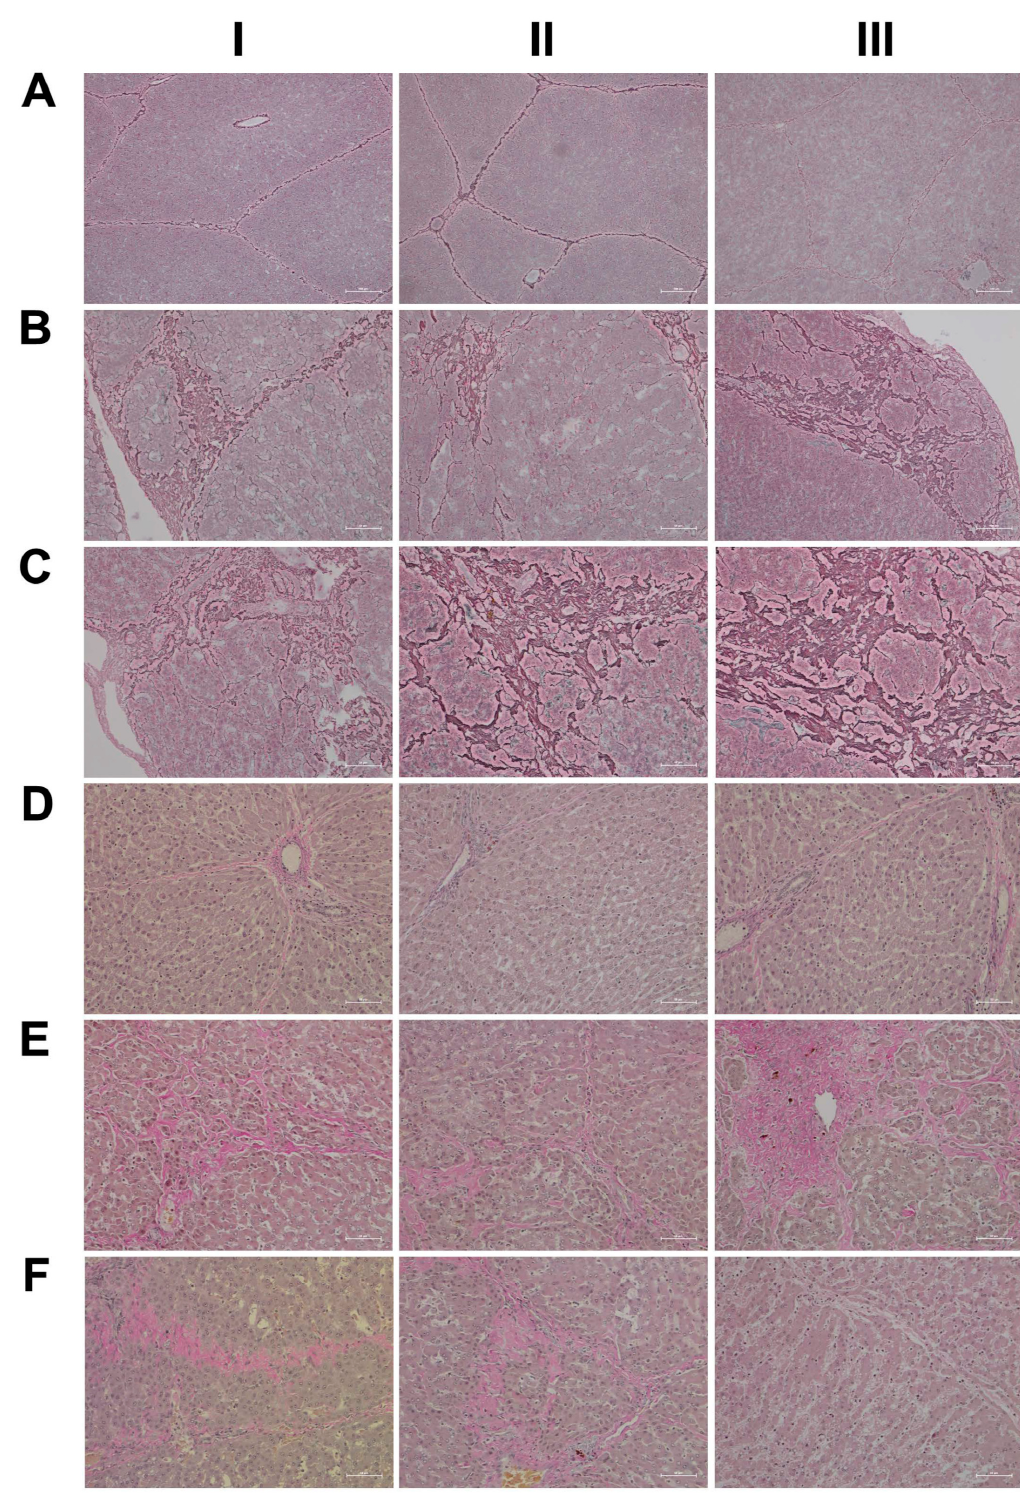
Figure 2. Silver and Elastica van Giesen stain of control and diclofenac-treated animals after daily dosing for 28 days. Panel AI–III: Silver staining of three individual control animals with normal